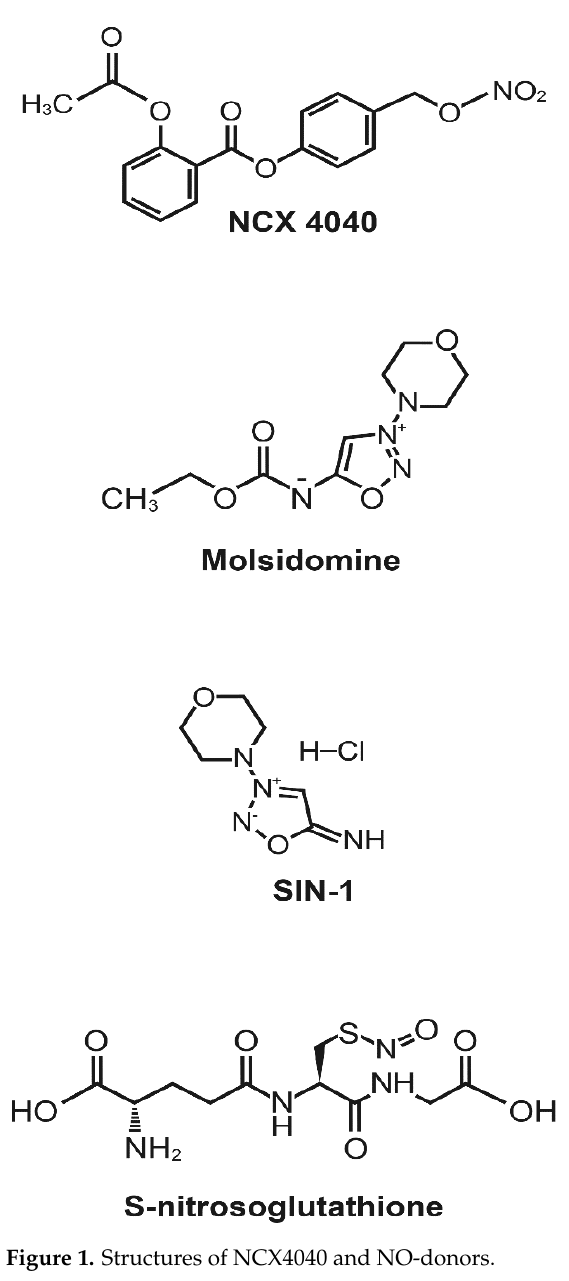
Figure 1. Structures of NCX4040 and NO-donors.